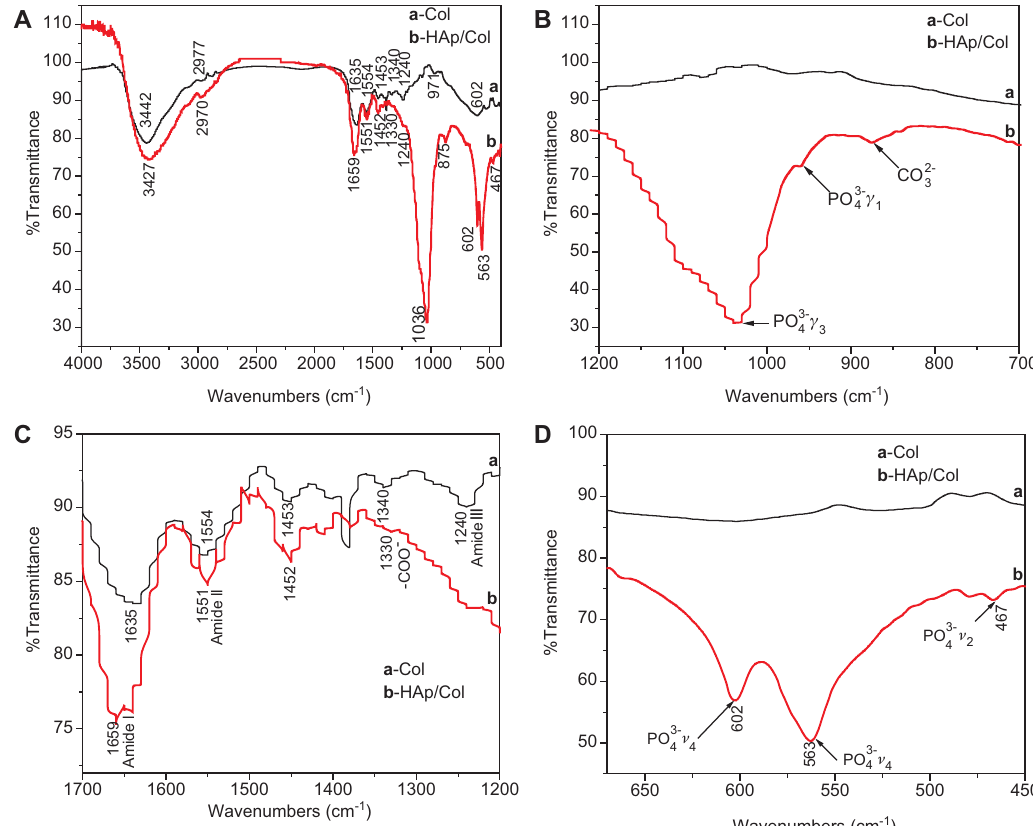
Figure 4 Comparative analysis of FT-IR spectra of Col and HAp/Col. (A) Spectrum for wavelength range of 400 – 4000 cm -1 ; (B) zoom-in spectrum for wavelength range of 700 – 1200 cm -1 ; (C) zoom-in spectrum for wavelength range of 1200 – 1700 cm -1 ; (D) zoom-in spectrum for wavelength range of 450 – 670 cm -1